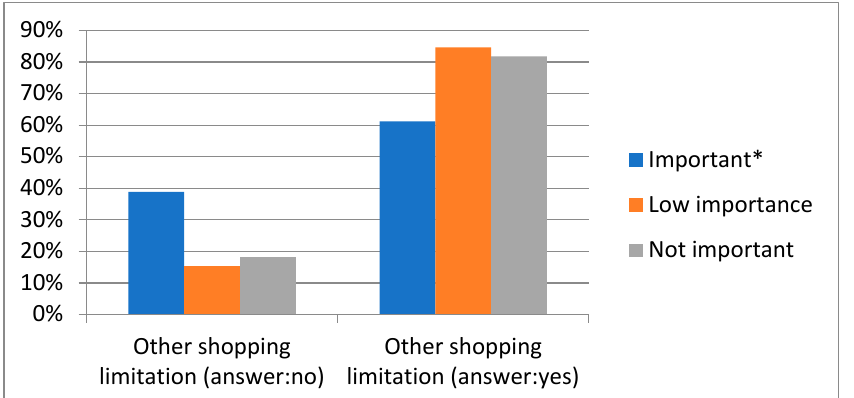
Figure 5. Graphic presentation of dependence of two variables: other shopping limitation and the importance of turning the city into an SC. Source: own elaboration. * The importance of turning the city into an SC.